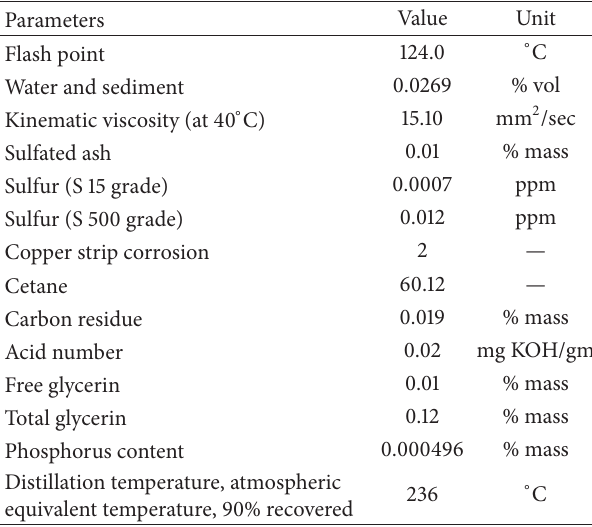
Table 2: Characterization of Pongamia Pinnata oil as per ASTM